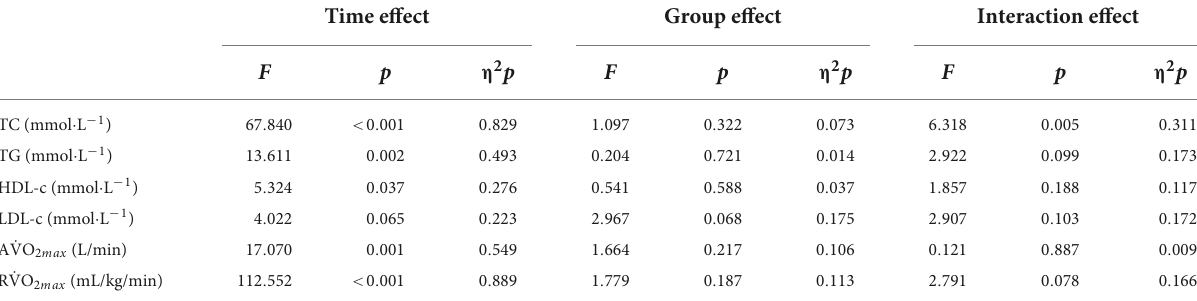
TABLE 6 Two-way ANOVA with repeated measures of blood lipids and